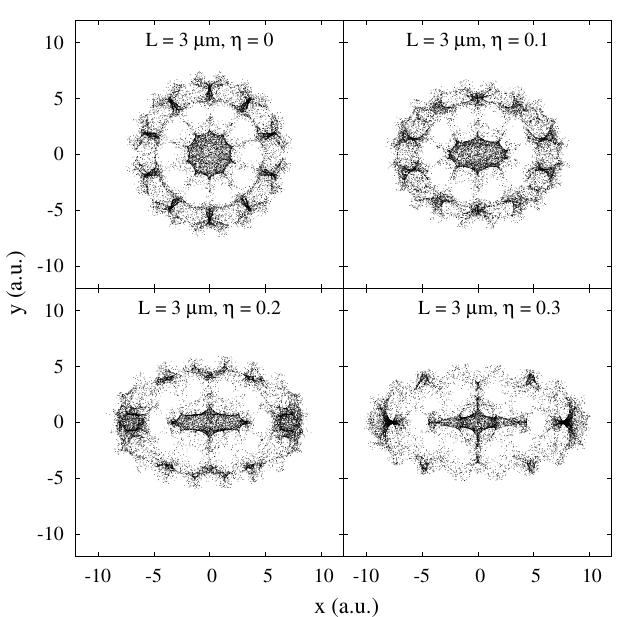
Figure 5. The spatial distributions of protons channeled in the radially deformed DWNTs(10, 0)@(5, 0) under different radial strains: (left top) η = 0; (right top) η = 0.1; (left down) η = 0.2; (right down) η = 0.3, respectively. The proton energy is E = 1 GeV and nanotube length is L = 3 µ